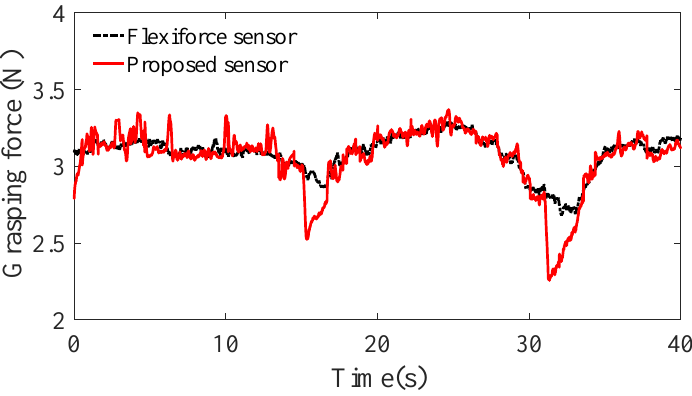
Figure 18. A comparison of grasping force measured by Flexiforce sensor and our proposed